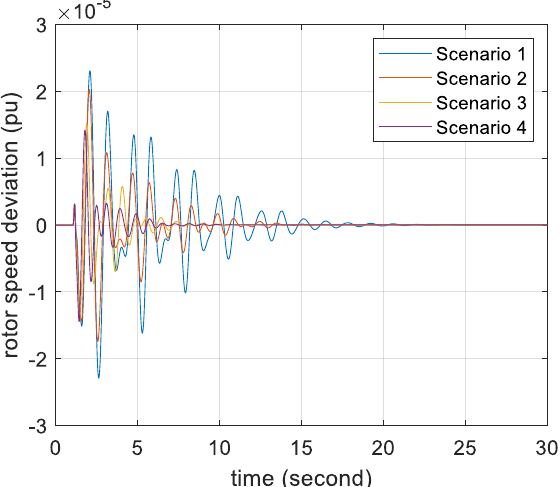
Figure 9. Rotor angle responses of G4.